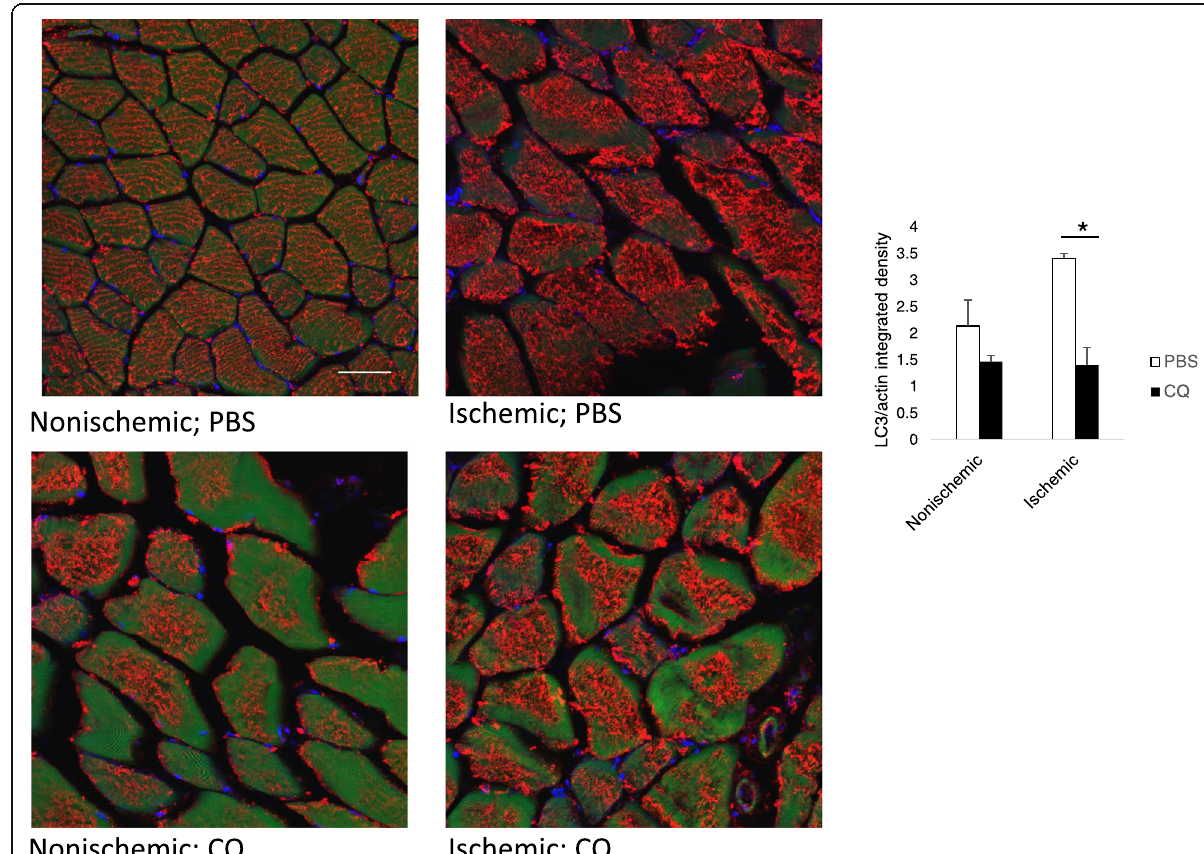
Fig. 1 CQ consolidates LC3 expression in ischemic muscle. Immunohistochemical analysis of cross sections of nonischemic and ischemic tibialis anterior (TA) muscle from WT (C57Bl6/J) mice at 24 h after femoral artery ligation (FAL) treated with either PBS or CQ (50 mg/kg) for 21 days prior to unilateral FAL. LC3 expression (red); actin expression (green); DAPI nuclear stain (blue); pattern of LC3 expression (diffuse versus consolidated) analyzed using integrated density analysis (Image J) and expressed as a function of actin per unit area. Five images per limb/animal were evaluated. Representative images shown. * p < 0.005, PBS:CQ, ischemic limb N = 3 mice per treatment, 5 images/limb for each